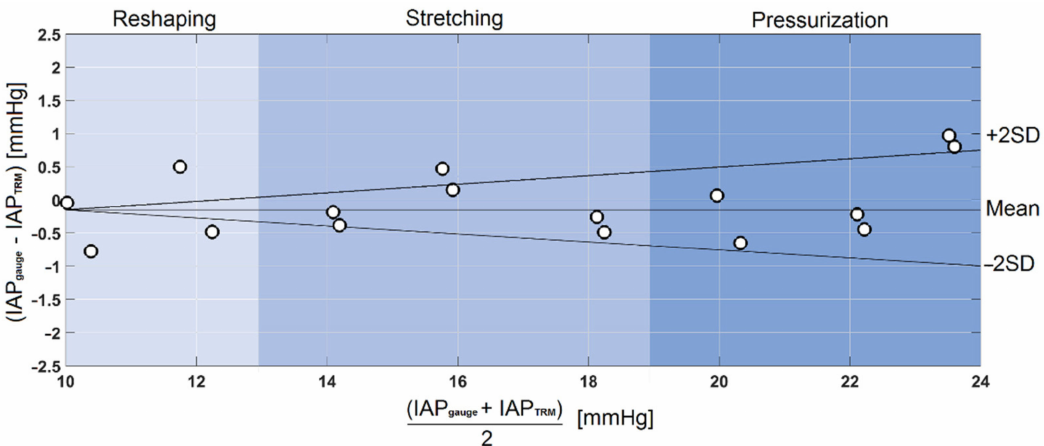
Figure 8. Bland and Altman’s analysis, which shows the mean, bias, and standard deviation of test measurements performed after calibrating the whole system for IAP measurements. A bias of − 0.06 mmHg was found between the IAP values obtained from the pressure gauge and